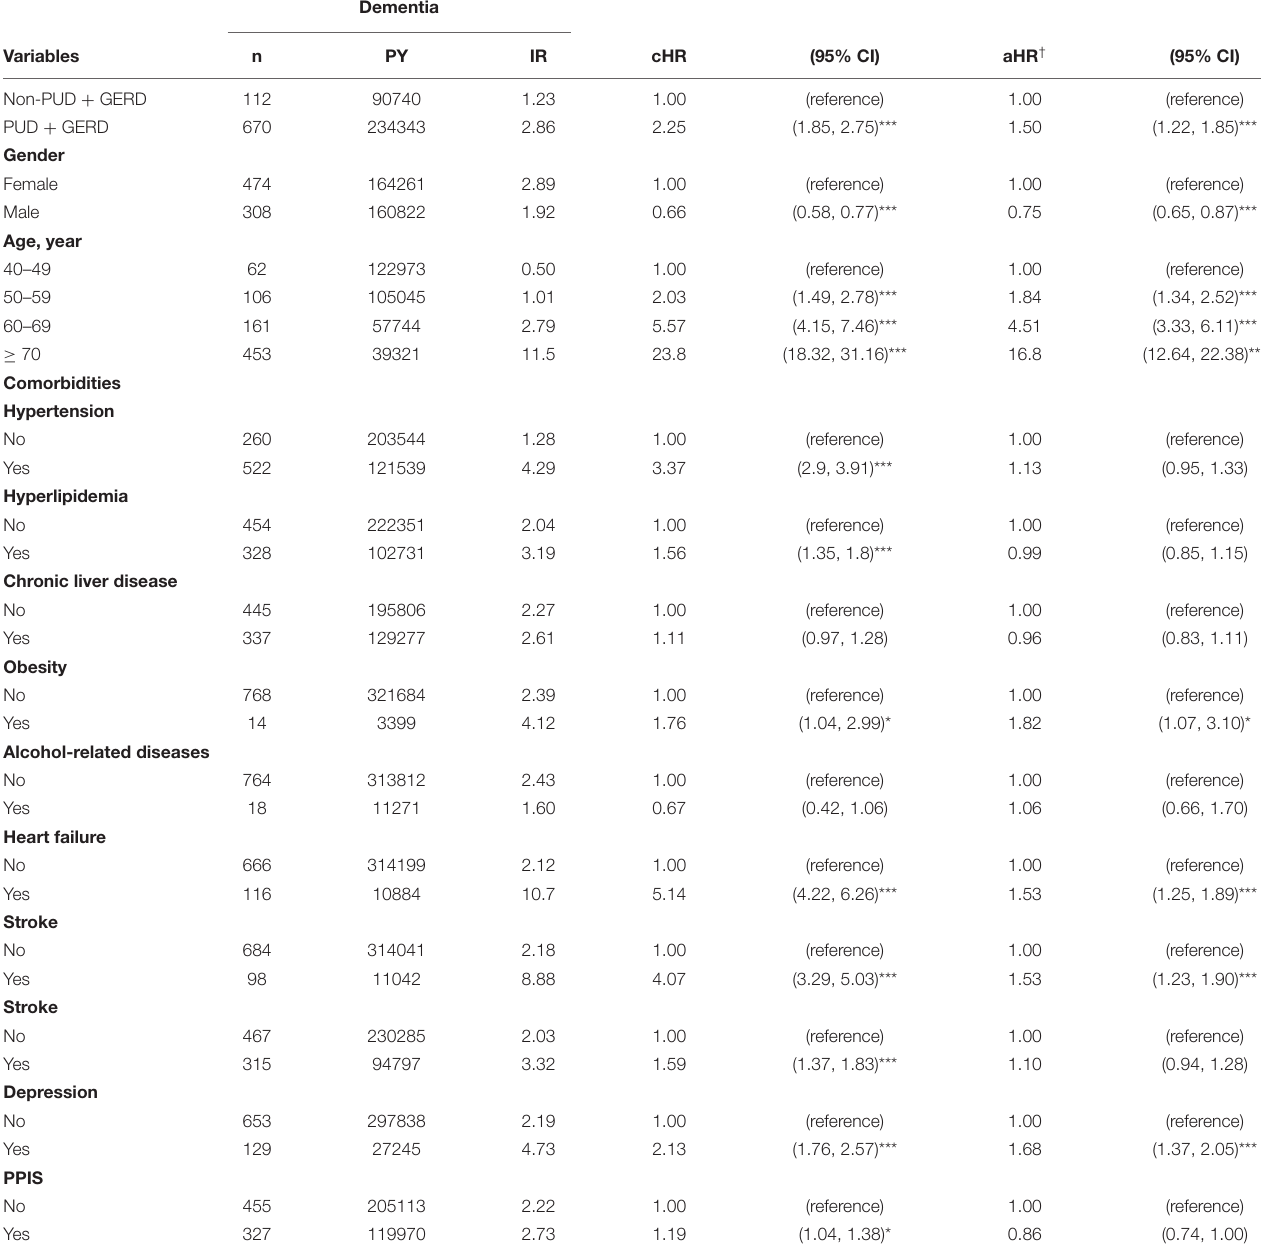
TABLE 4 | Sensitivity Analysis: Population with peptic ulcer disease (PUD) or GERD.